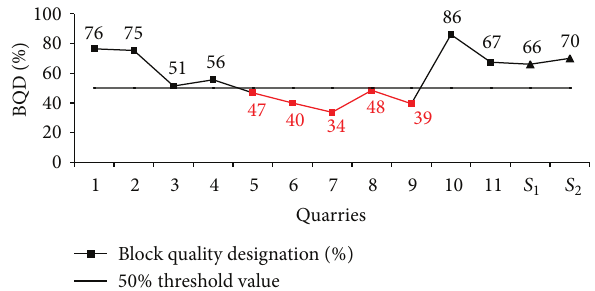
Figure 1: Rock mass block quality designation (BQD) ratios of the Karaburun limestone quarries. 𝑆 1 and 𝑆 2 : working S¨upren marble quarries (Nefeslioglu et al.